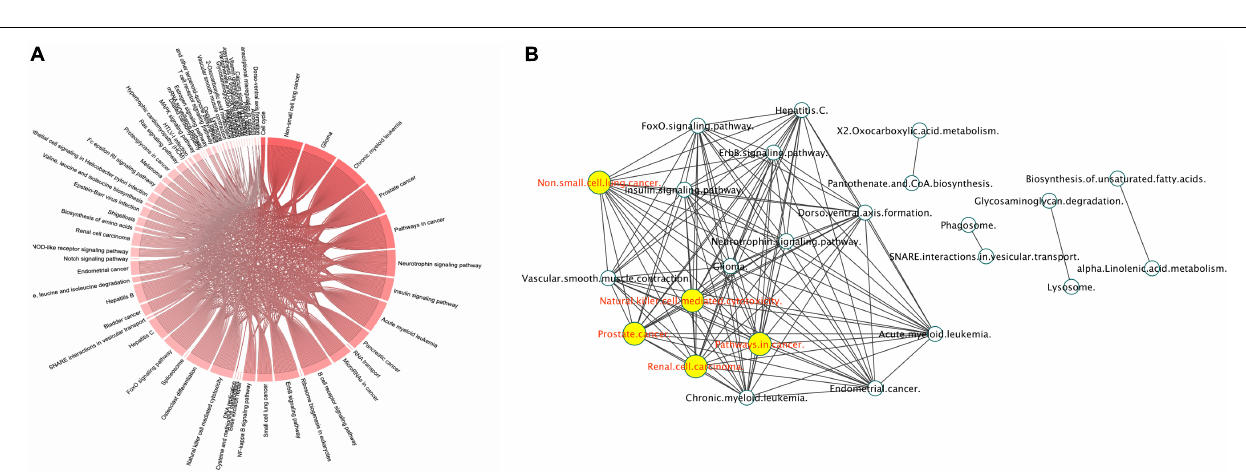
FIGURE 7 | Protein expression mediated by γ -valerolactones treatment in human brain microvascular endothelial cells and their relationship with endothelial cell functions. HBMEC cells exposed to the mixture of gut metabolites ( γ -valerolactones) for 20 h and cells induced under stress by 4 h-incubation with TNF- α were used in a shotgun proteomic analysis to determine the differential expression of proteins between groups. An enrichment pathway analysis of miRNAs targets in GeneTrial was also performed. (A) Proteins differentially expressed mapped onto KEGG, Biocarta, and Wikipathways modules associated with endothelial cell function, cell metabolism, cell signaling pathways, and others. (B) Proteins-enriched pathway interactions network, pathway interactions network built in Cytoscape software to show the connections (edges) between enriched pathways (nodes) by proteins differentially expressed. Hubs network components are highlighted by yellow circles.